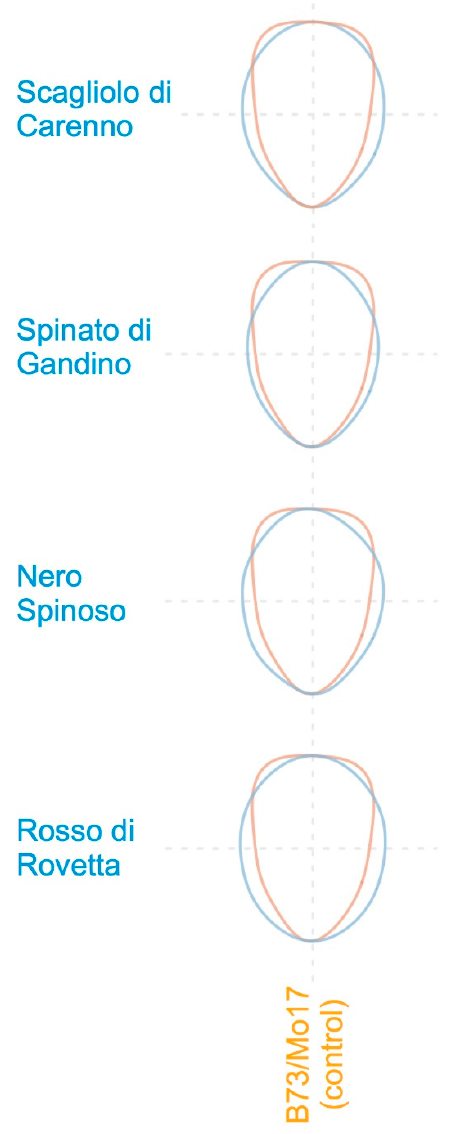
Figure 3. Comparison between the mean shape of the kernels of B73/Mo17 (control) (orange lines) and that of the other maize genotypes (blue lines).